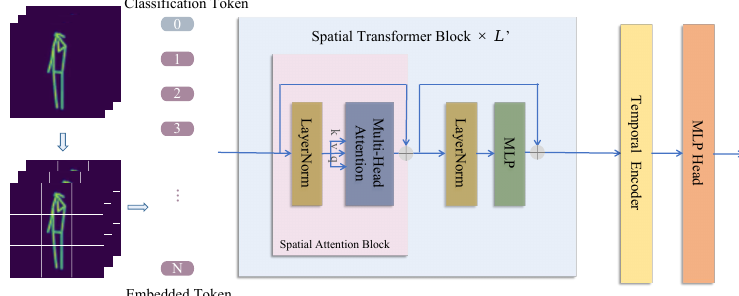
Figure 4. The Transformer blocks of the skeleton stream to process skeleton